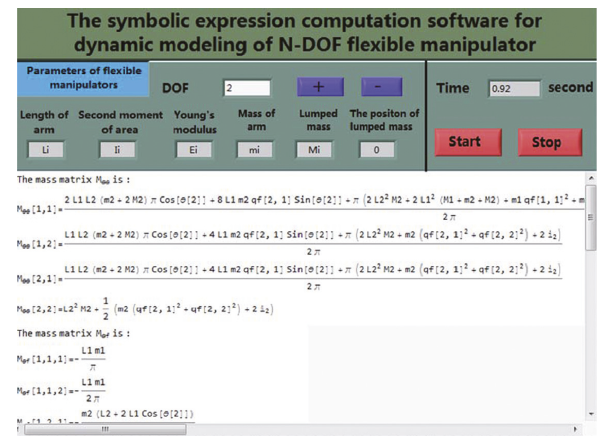
Figure 4: Operating interface of symbolic expressions calculation